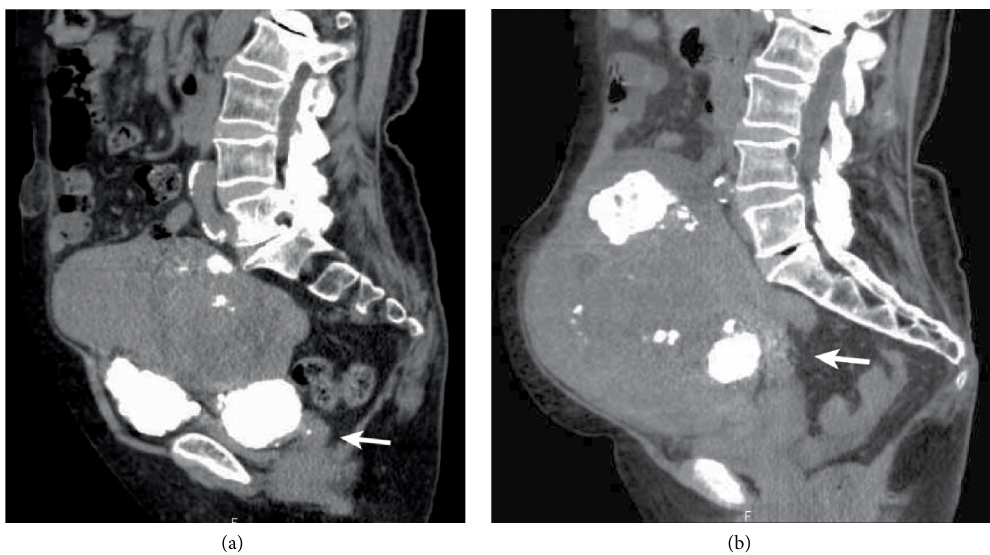
Figure 2: CT findings of the cervix. (a) Axial section of the lower abdomen one year before the uterine torsion. (b) Axial section of the lower abdomen at the time of uterine torsion. The cervix was elongated and moved upward compared with its position one year before